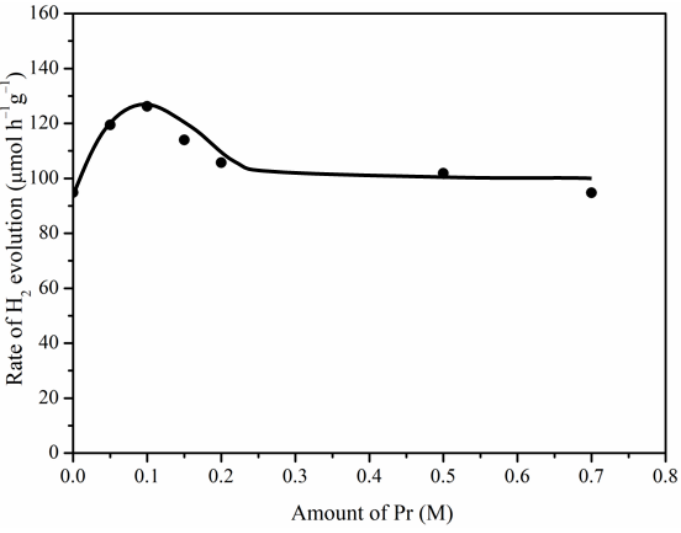
Figure 6. Photocatalytic activity of different molar concentrations of Pr doping in LaFeO 3 under visible light irradiation.